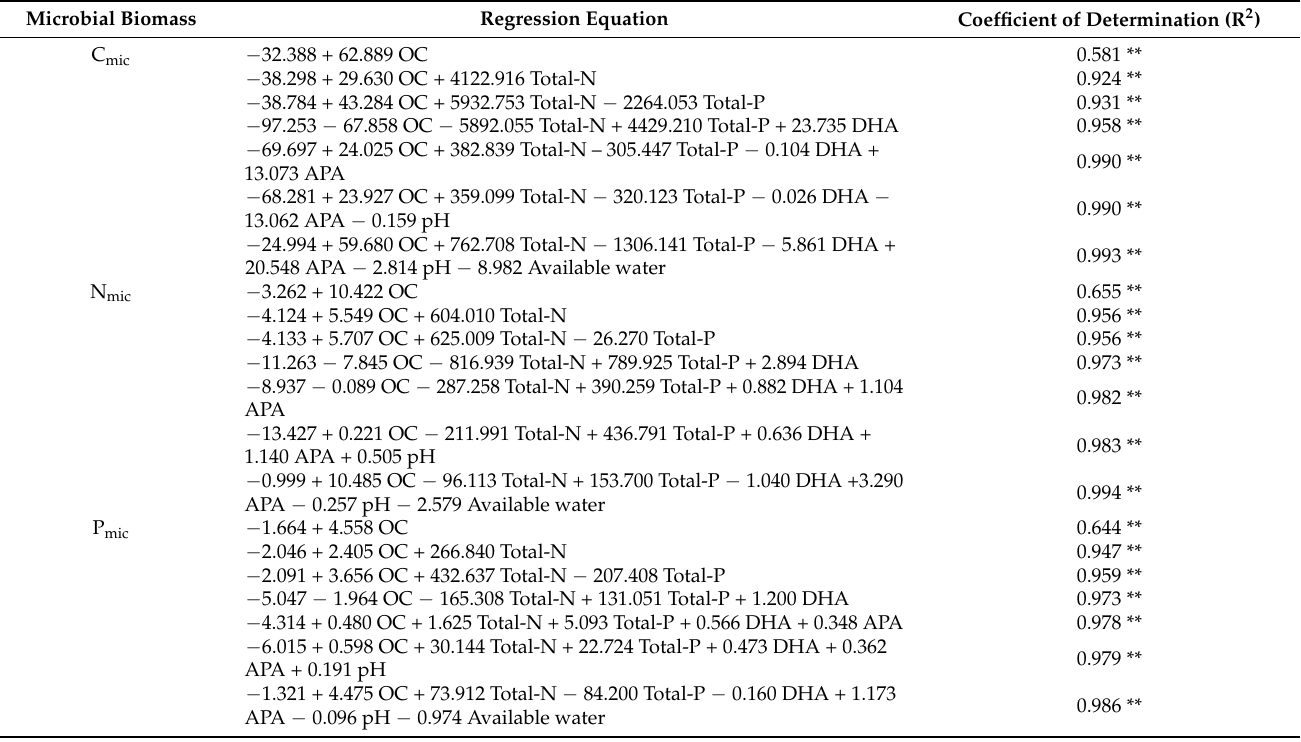
Table 4. Effect of soil properties on predictability of microbial biomass C, N, and P in soil. Microbial Biomass Regression